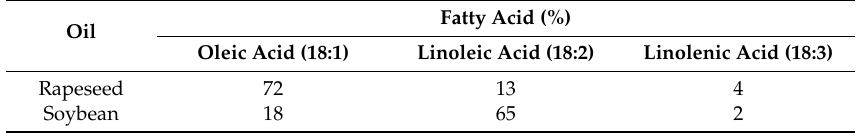
Table 2. Fatty acid composition of oil